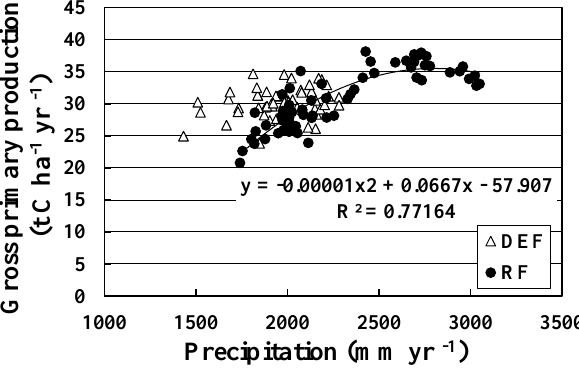
Fig. 6. The relationship between annual precipitation and gross pri- mary production estimated by the VISIT